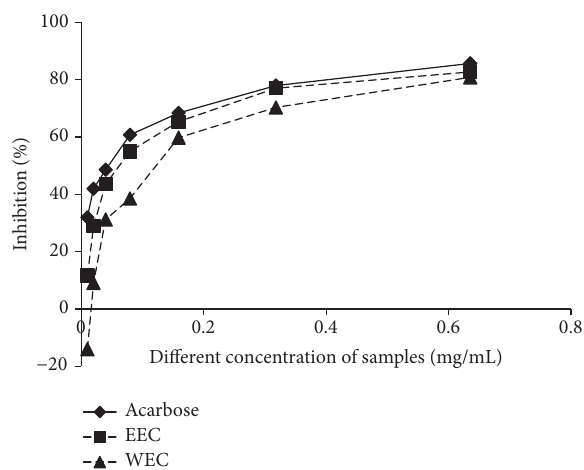
Figure 4: Inhibitory activities of CTF extracts against 𝛼 -glycosidase. The experiment was performed with triplicates. Two independent experiments showed similar results.